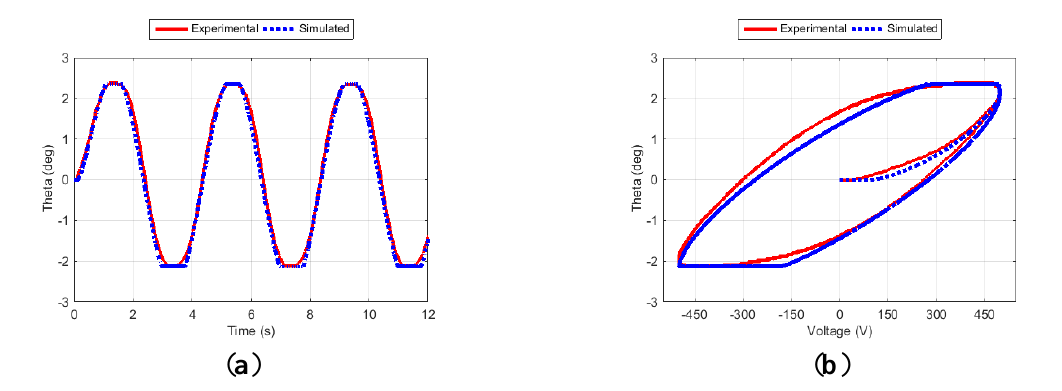
Figure 12. Fin angle ( a ) and hysteresis curve ( b ) for Case